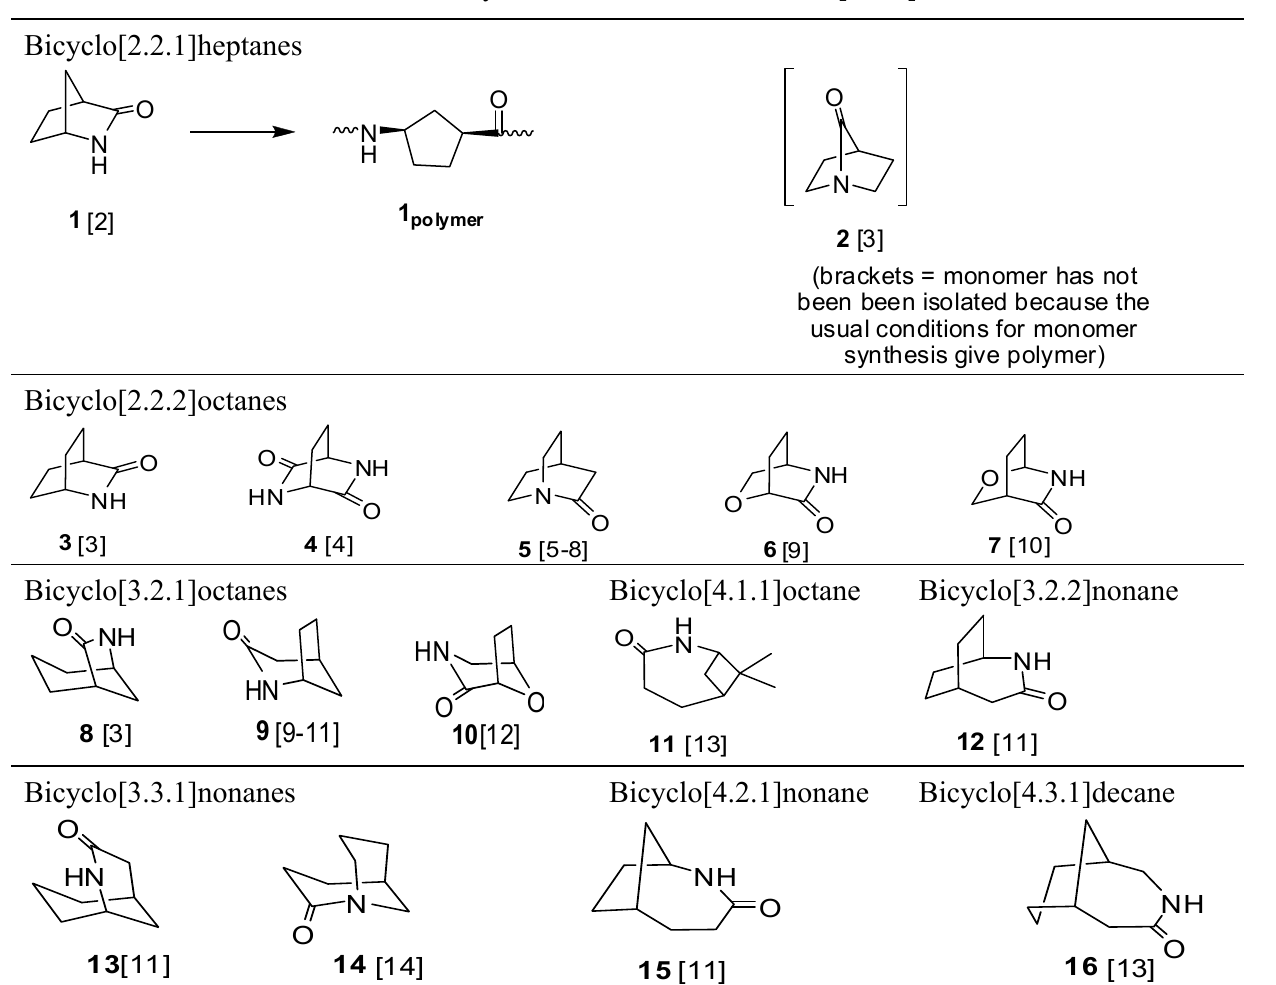
Table 1. Bicyclic lactam monomers 1–16